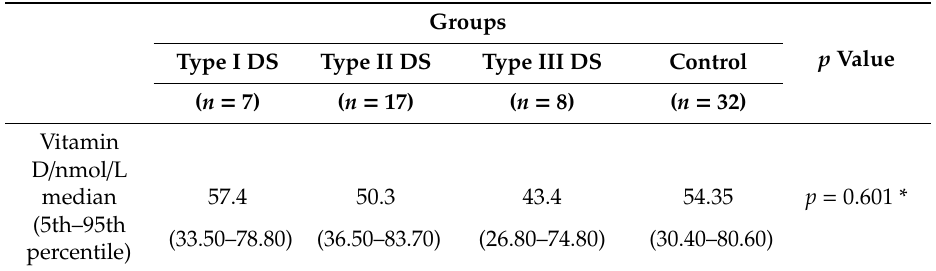
Table 3. Serum vitamin D level depending on denture stomatitis severity.